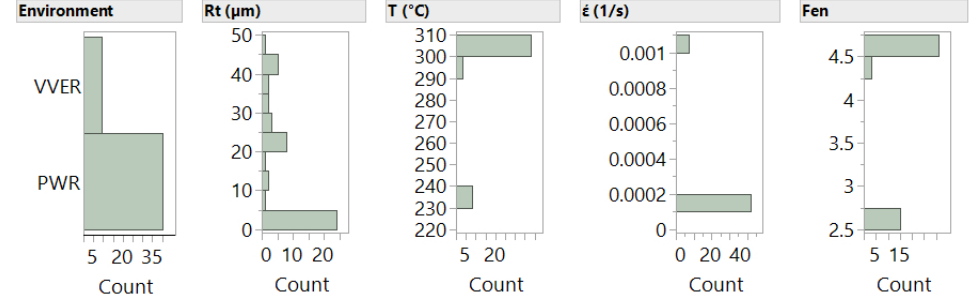
Figure 7. Distribution of the factors in the low F en programme.